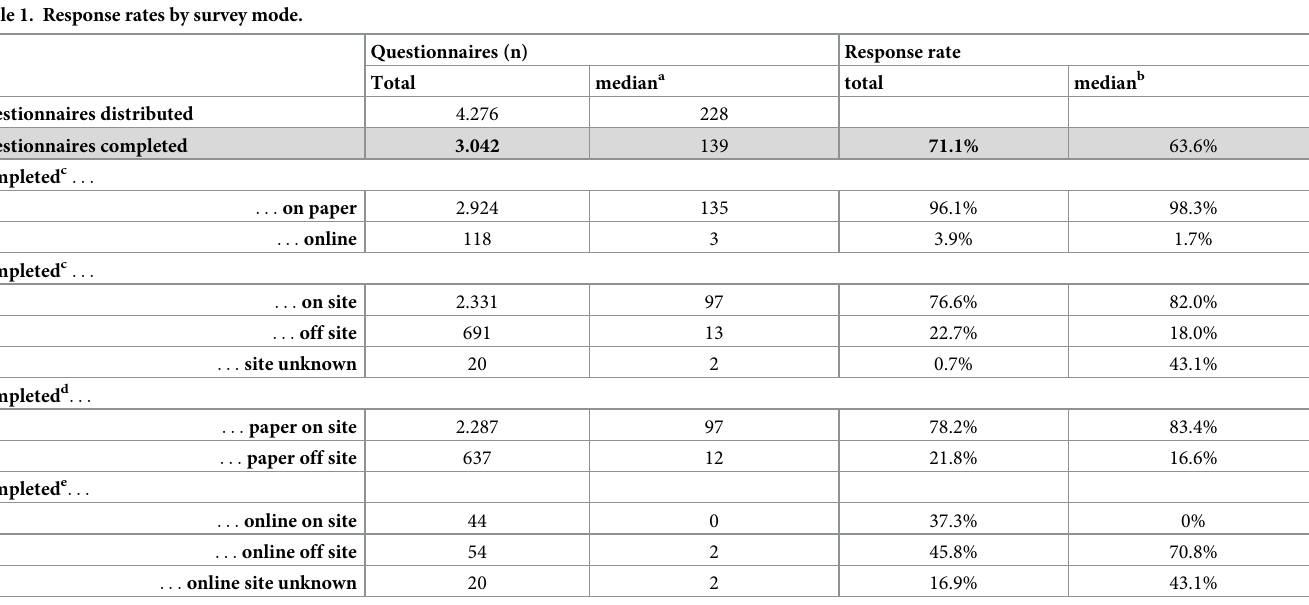
Table 1. Response rates by survey mode.